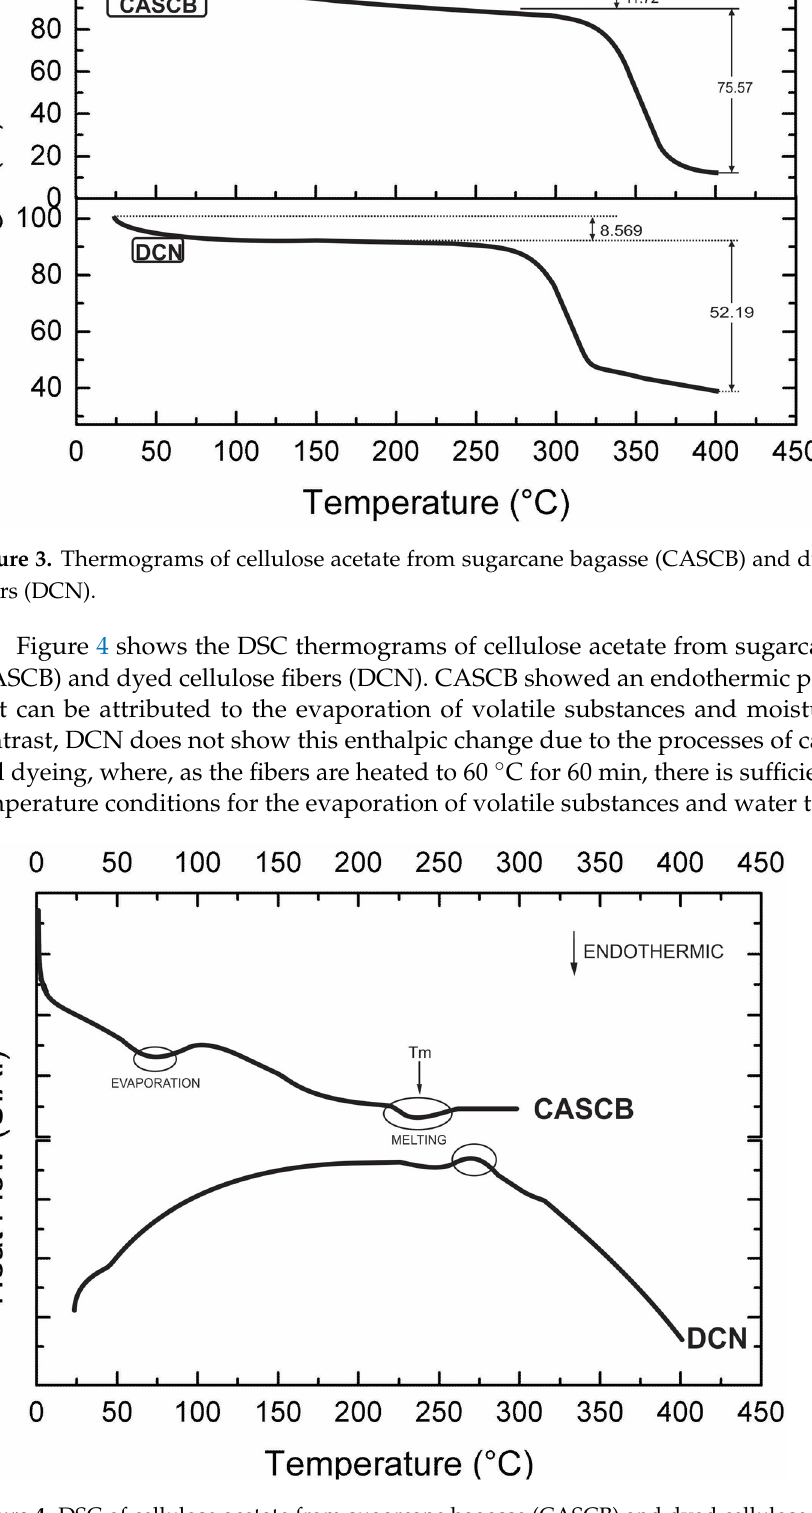
Figure 4. DSC of cellulose acetate from sugarcane bagasse (CASCB) and dyed cellulose fibers (DCN).